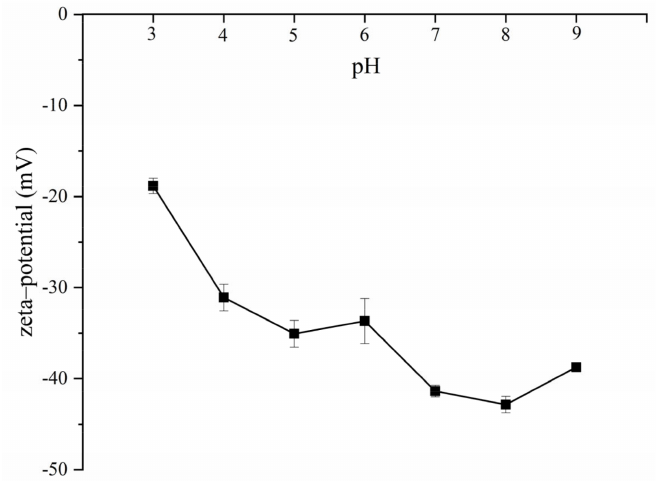
Figure 4. Influence of pH on the zeta–potential of zein–GA–TA gel particle